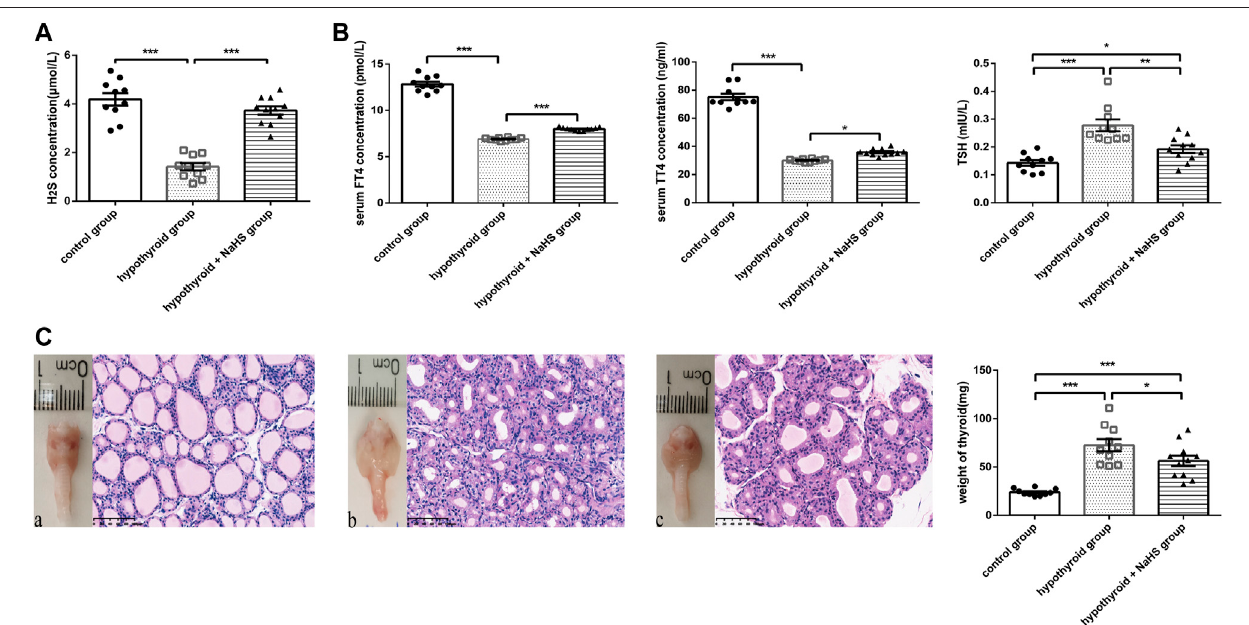
FIGURE 3 | The effect of H 2 S on thyroid function in hypothyroid rats. (A) The H 2 S levels in rat serum of control group ( n = 10), hypothyroid group ( n = 10) and hypothyroid + NaHS group ( n = 11) were analyzed by H 2 S-selective sensor. H 2 S level was signi fi cantly lower in hypothyroid group and NaHS treatment improved H 2 S levelinhypothyroidrats. (B) SerumFT4andTT4levelsinthecontrolgroup( n =10),hypothyroidgroup( n =10)andhypothyroid+NaHSgroup( n =11)weremeasuredby ELISA,andTSHlevelswereassayedbyradioimmunoassay.NaHStreatmentimprovedthyroidfunctioninhypothyroidrats. (C) Anteriorviewsofthyroidglandsand their related histologicalchanges with H&E staining (magni fi cation, ×200), and the weight ofthyroids in different groups are shown. Control group (a), hypothyroid group (b),hypothyroid + NaHS group (c). NaHS treatment alleviated thyroid enlargement in hypothyroid rats. * p < .05, ** p < .01, *** p < .001, **** p < .0001. Dataare expressed as the mean ± SEM and n = 10 – 11 per group. H 2 S, hydrogen sul fi de; NaHS, sodium hydrosul fi de; FT4, free triiodothyronine; TT4, total thyroxine; TSH, thyroid- stimulating